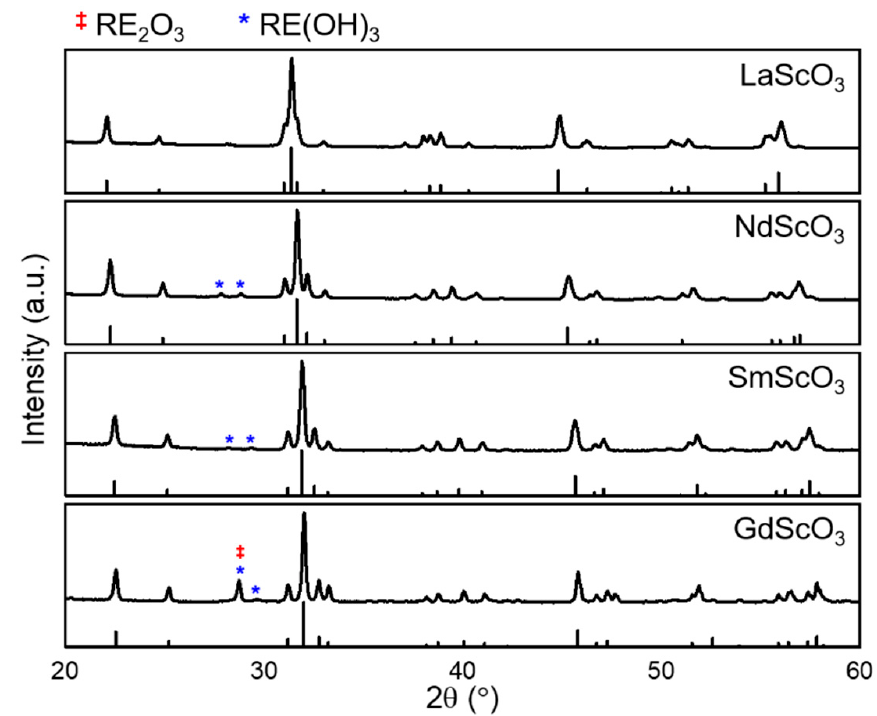
Figure 3. PXRD patterns of REScO 3 (RE = La, Nd, Sm, Gd) particles obtained using the two-step heat treatment at 450 °C for 2 days and then 300 °C for 1 day. The calculated patterns for the corresponding REScO 3 are plotted below. The perovskite phase was the primary product, with trace RE(OH) 3 (blue *) or RE 2 O 3 (red ‡ ) as secondary products.